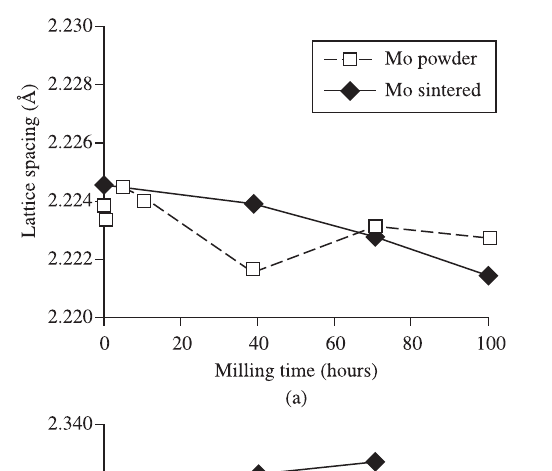
Figure 4. X ray diffraction of the powder mixture vs. milling time.